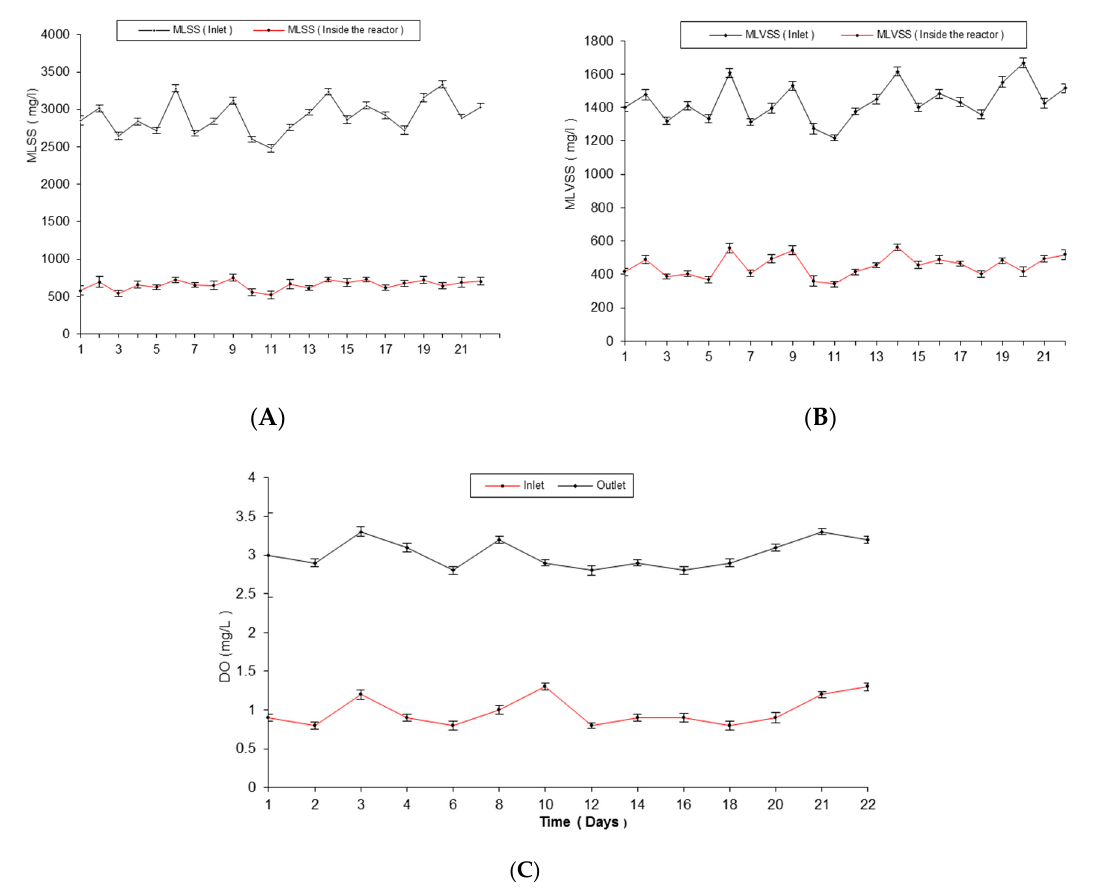
Figure 4. ( A ) MLSS profile in continuous mode aerobic digester (MBBR sludge); ( B ) MLVSS profile in continuous mode aerobic digester (MBBR sludge); ( C ) DO profile in continuous mode aerobic digester (MBBR sludge).